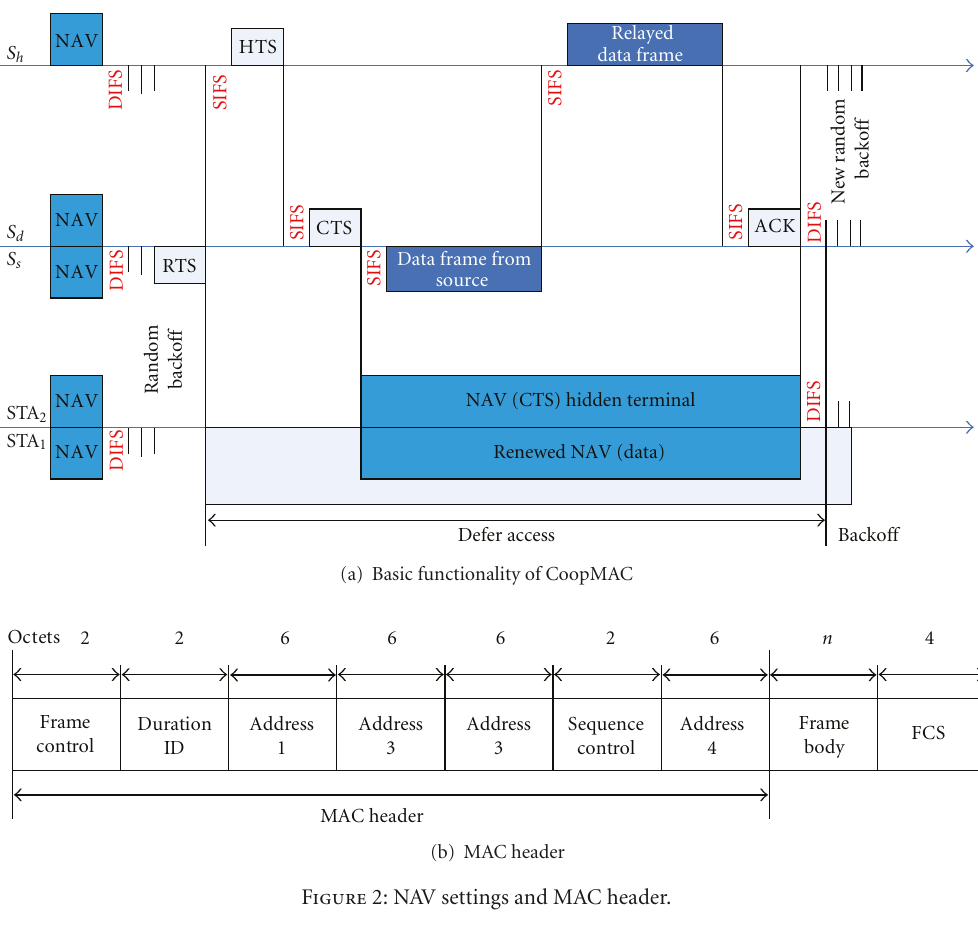
Figure 2: NAV settings and MAC header.